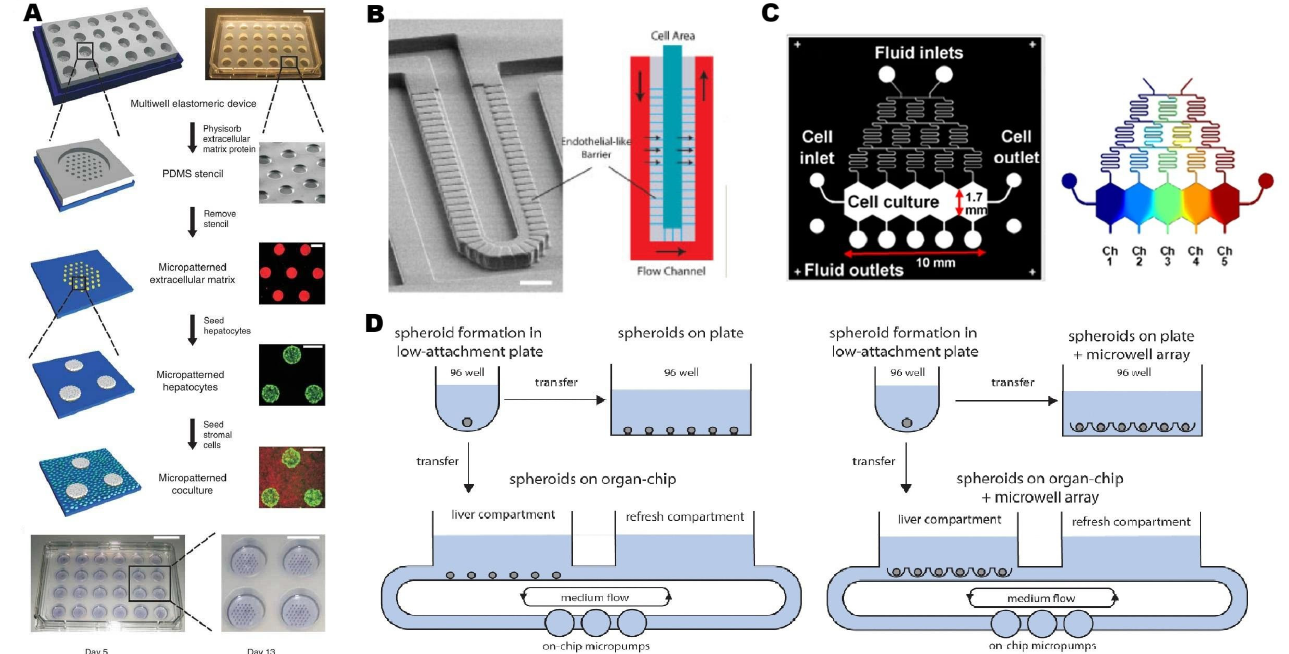
Figure 2. Different microfluidic models are used to construct liver-on-a-chip. ( A ) A 24-well PDMS mold with through holes at the bottom. Hepatocytes (labeled green) selectively adhered to the collagen structure, clustered together, and then surrounded by mouse 3T3-J2 fibroblasts (labeled orange). ( B ) Microfluidic endothelial-like barrier. The barrier consists of parallel channels connecting the cell culture zone with the external flow channel. ( C ) Simulation of liver lobules in Christmas tree structure, with gradient generator. ( D ) Spheroid culture. Cultured spheroids in an ultra-low-attachment plate, transferred them to a 96-well plate or liver chip and compared their performance. ( A ) reproduced with permission of [11], Copyright © 2008. Published by Nature Publishing Group. ( B ) reproduced with permission of [78], Copyright © 2007. Published by Wiley Periodicals, Inc. ( C ) re- produced with permission of [79], Copyright © 2018. Published by Nature Publishing Group. ( D ) reproduced with permission of [80], Copyright © 2022 Published by Elsevier.